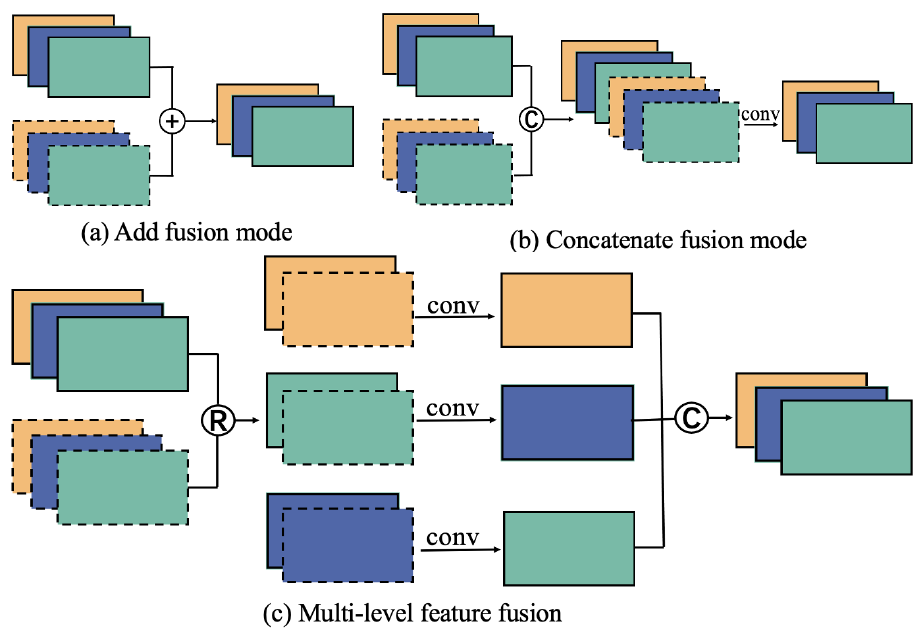
Figure 5. Detailed description of simple feature fusion and multi-level feature